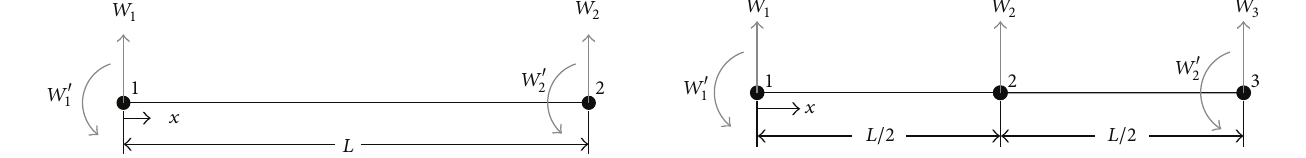
Figure 4: The 3-node, 5-degree-of-freedom beam